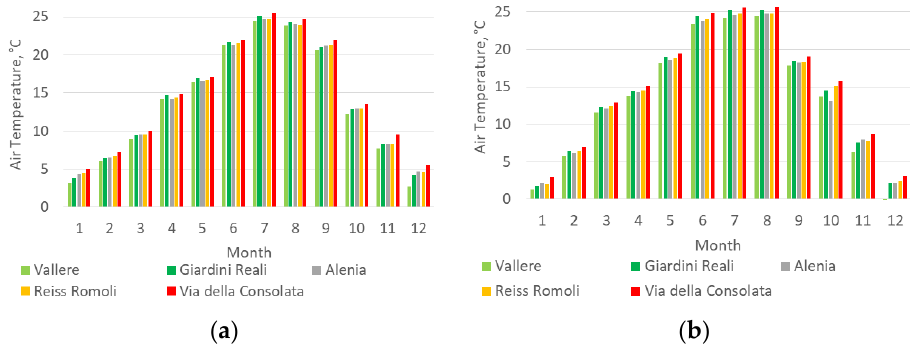
Figure 7. Monthly air temperatures of the five WS measurements: ( a ) 2016; ( b ) 2017.